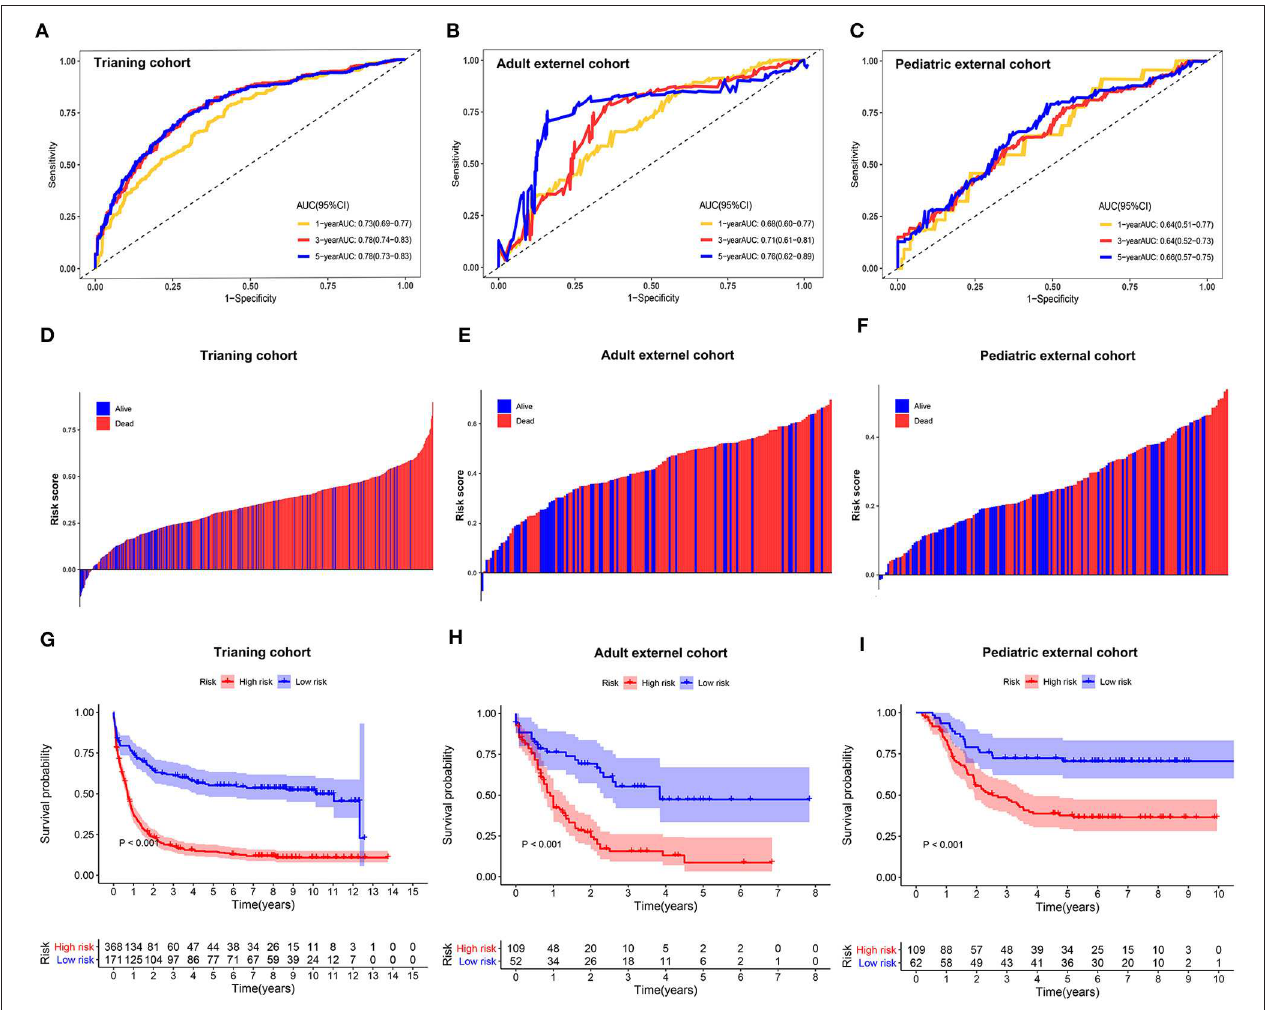
FIGURE 2 | Time-dependent receiver operating characteristic (ROC) analysis, survival outcome analysis, and Kaplan–Meier analysis of the nine-gene signature in acute myelogenous leukemia (AML). (A–C) Time-dependent ROC analysis for 1-, 3-, and 5-year overall survival (OS) of prognostic model in training cohort, adult external cohort, and pediatric external cohort, respectively. (D–F) Distribution of risk metabolic score in survival outcome analysis for training cohort, adult external cohort, and pediatric external cohort. (G–I) Kaplan–Meier curve of the prognostic model in the training cohort, adult external cohort, and pediatric external